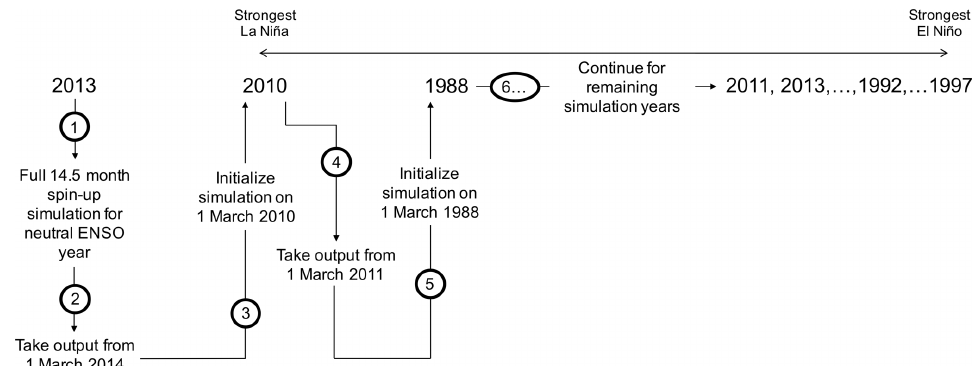
Figure 2. Flowchart depicting the “daisy-chain” simulation method.